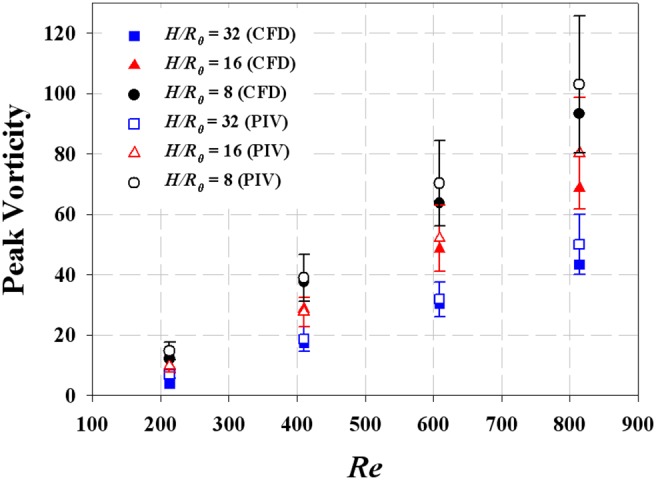
Comparison of normal-direction peak vorticity magnitude at the outlet of the helical tubes obtained from PIV and CFD.
Rc/R0 are fixed to 1.0. The error bars indicate 95% confidence limits. The helical graft of H/R0 = 4 was omitted for the clarity of the figure because its data overlaps with the others.